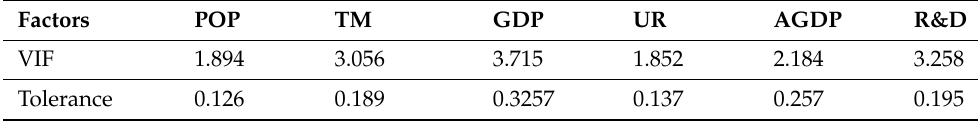
Table 3. Multiple collinearity test for